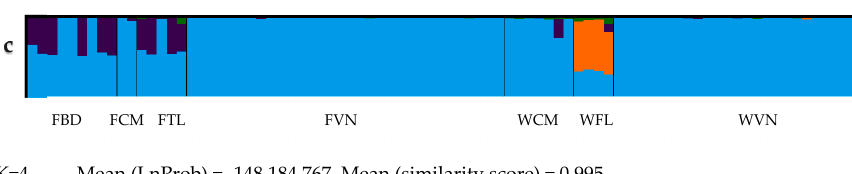
Figure 3. Structure results with K = 2, 3 and 4 according to subfigure a , b and c . Results were plotted against CLUMPAK web-based indicated the population structure of striped catfish in this study (Subfigure a and b ). The one big population comprised FCM, FVN, WCM and WVN; the second is the near standalone WTL (presented in three subfigures) and other populations (FTL & FBD) were admixture to Vietnam and Cambodia populations. Abbreviations are given in Table 1.